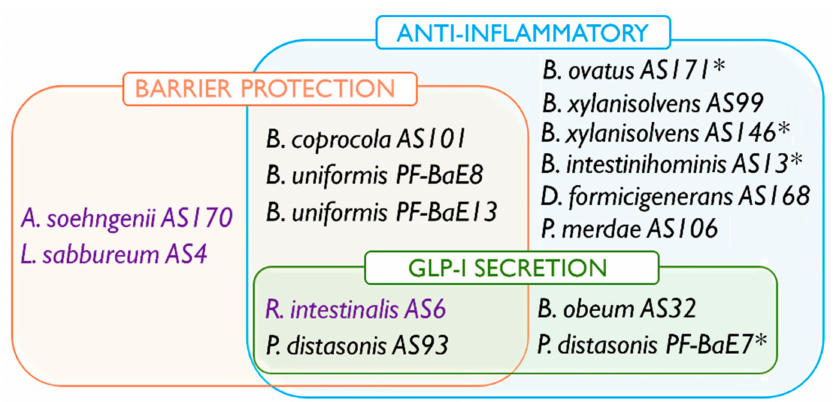
Figure 6. Diagram summarizing the beneficial properties of candidates as next-generation probiotics. Out of the 21 selected strains, 15 exhibited at least one statistically significant effect in the in vitro models including 7 strains that combined beneficial activities. Strains able to produce butyrate are highlighted in purple; note that AS4 produced only a limited amount of butyrate in the tested conditions. * indicates the bacterial strains which survived 2 h of gastric